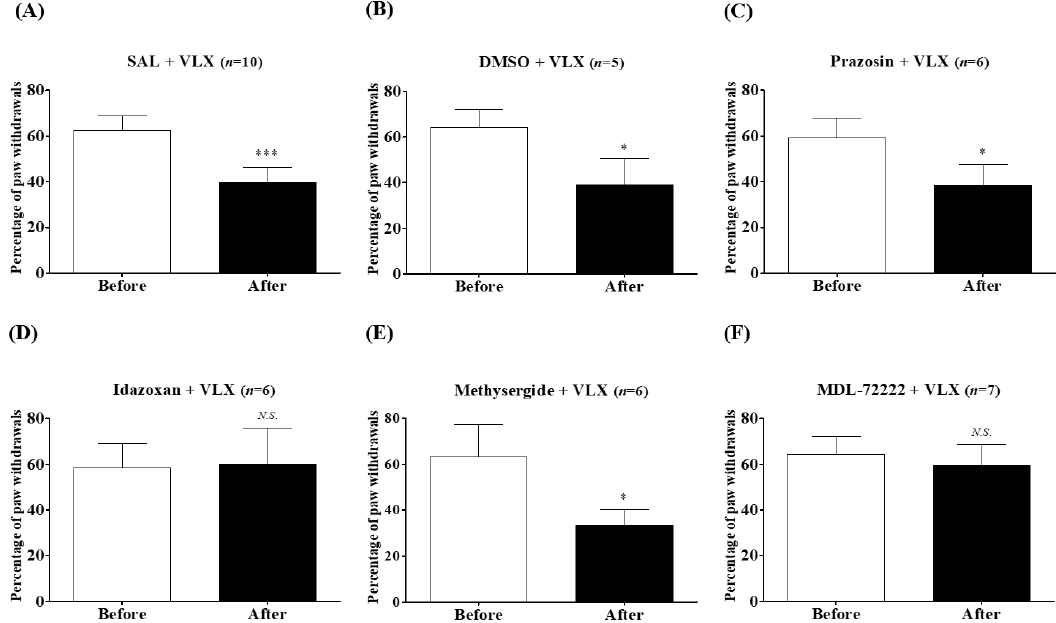
Figure 6. Effects of intrathecal injection with α -adrenergic or serotonergic antagonists on the analgesic action of VLX against mechanical allodynia. Mice with mechanical nociception were divided arbitrarily into six groups: saline (SAL), DMSO, prazosin, idazoxan, methysergide and bemesetron (MDL-72222) were intrathecally (i.t.) injected 20 min before VLX (VLX, 40mg/kg, i.p.) treatment ( A – F , respectively). Then measurements were performed just before the i.t. injection (Before) and 60 min after VLX treatment (After). Data was expressed as mean ± S.D.; N.S. , no significance ( p > 0.05); * p < 0.05, *** p < 0.001, vs. Before; by paired t -test.